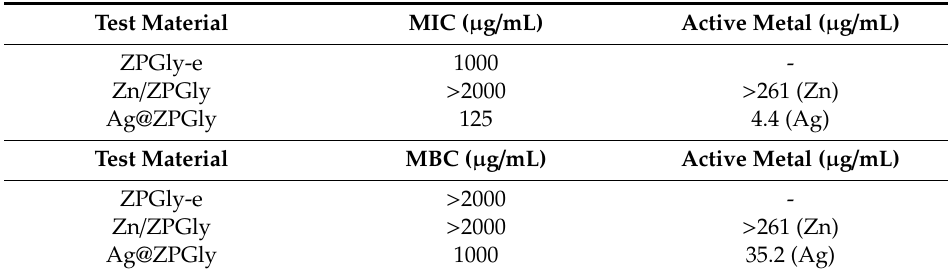
Table 1. MIC and MBC values for zirconium phosphate / phosphonate dispersions tested on S. epidermidis RP62A.